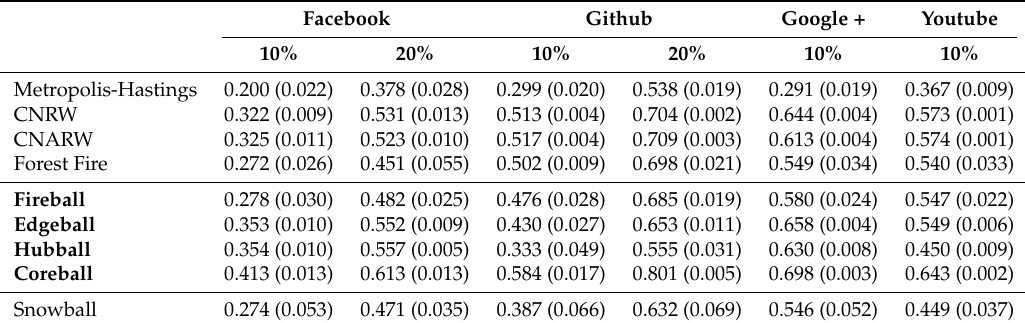
Table 7. IVIP score (higher is better) for the different datasets, averaged over 10 sampling runs for each dataset (standard deviation is shown between